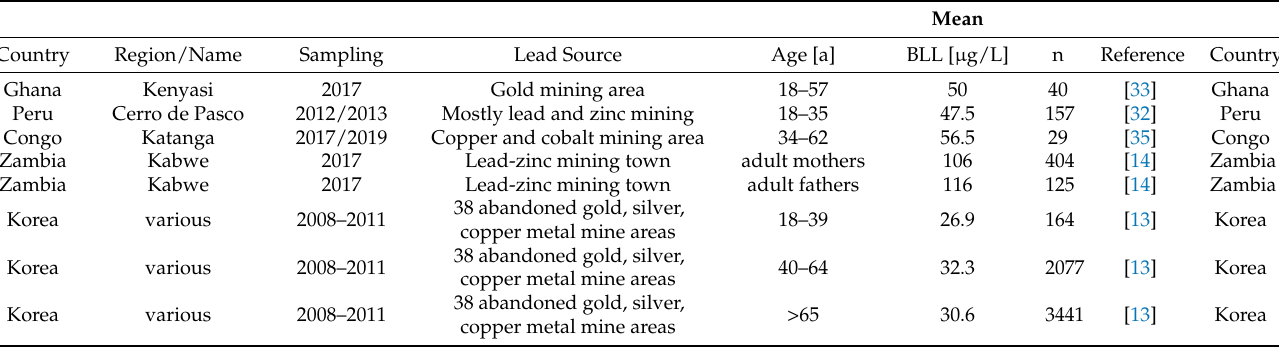
Table 4 summarizes exemplary data for adults in other scientific work (s. Table 4). Table 4. Comparison of our study to similar studies for